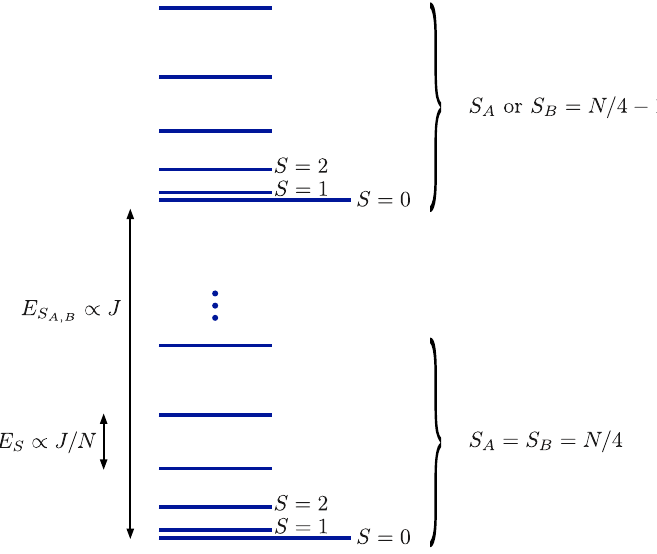
Figure 2.5: The states with lowest energy in the Lieb-Mattis